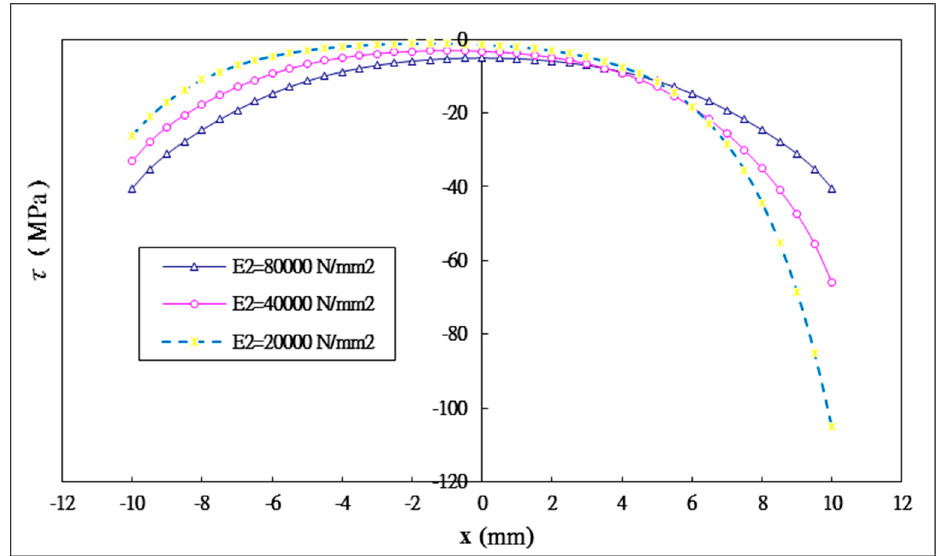
Figure 13. Shear stress distribution in the adhesive with three different Young’s moduli of the inner adherend.